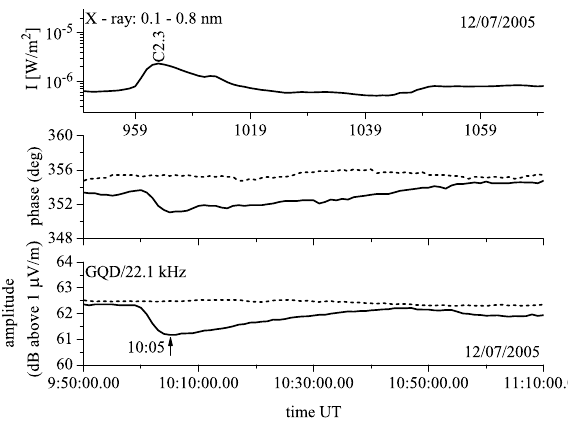
Fig. 4. Time variation of X-ray irradiance, GQD signal phase and amplitude during C2.3 (10:03) event on 12 July 2005 – solid lines. Extrema indicated by arrows and the corresponding UT. Phase and amplitude on the quiet day 8 July 2005 – dashed lines.